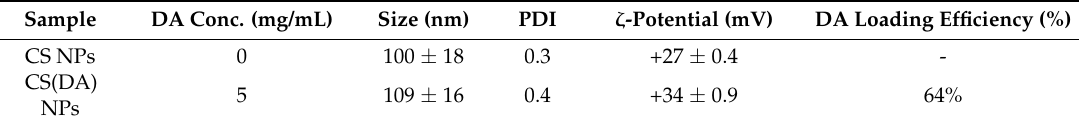
Table 1. Physico-chemical properties of the CS and CS(DA) NPs in PBS